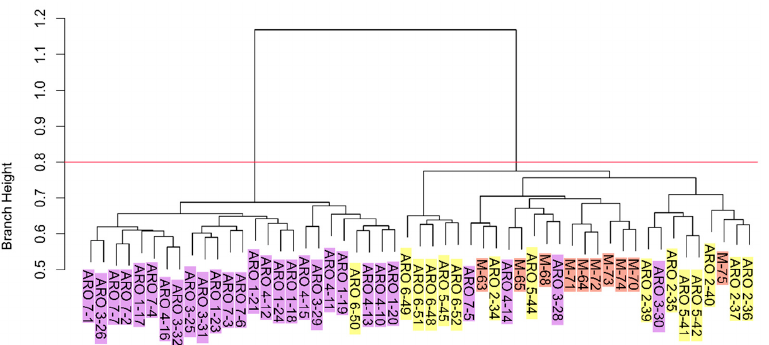
Figure 4. Hierarchical clustering. Labels at the leaves of the dendrogram indicate the population ID (ARO1-7 and M) and the individual ID number. Purple, yellow, and orange label highlighting indicate sampling of individuals within the ARO_K1, ARO_K2 and M populations, respectively. The red line cuts the dendrogram for two major genetic clusters. Pairwise estimates of the Wright’s F ST statistics ranged from 0 (ARO3 vs. ARO1, ARO4 vs. ARO3, and ARO7 vs. ARO1) to 0.113 (ARO5 vs. ARO7) (Table 1). Permutation analysis on F ST estimates indicated, for the p = 0.05 threshold, non-significant differences among the ARO_K1 populations, and significant differences between any of the ARO_K1